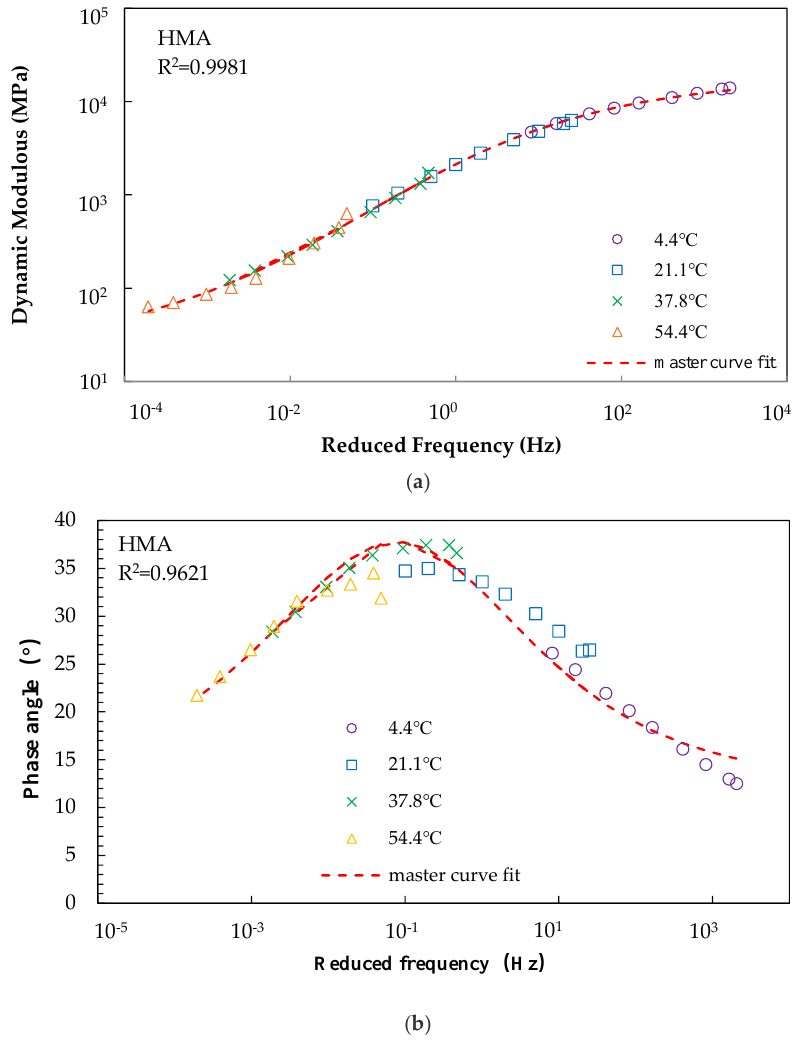
Figure 2. Master curve fits to experimental data at reference temperature of 21.1 °C for ( a ) Dynamic modulus; ( b ) Phase angle.